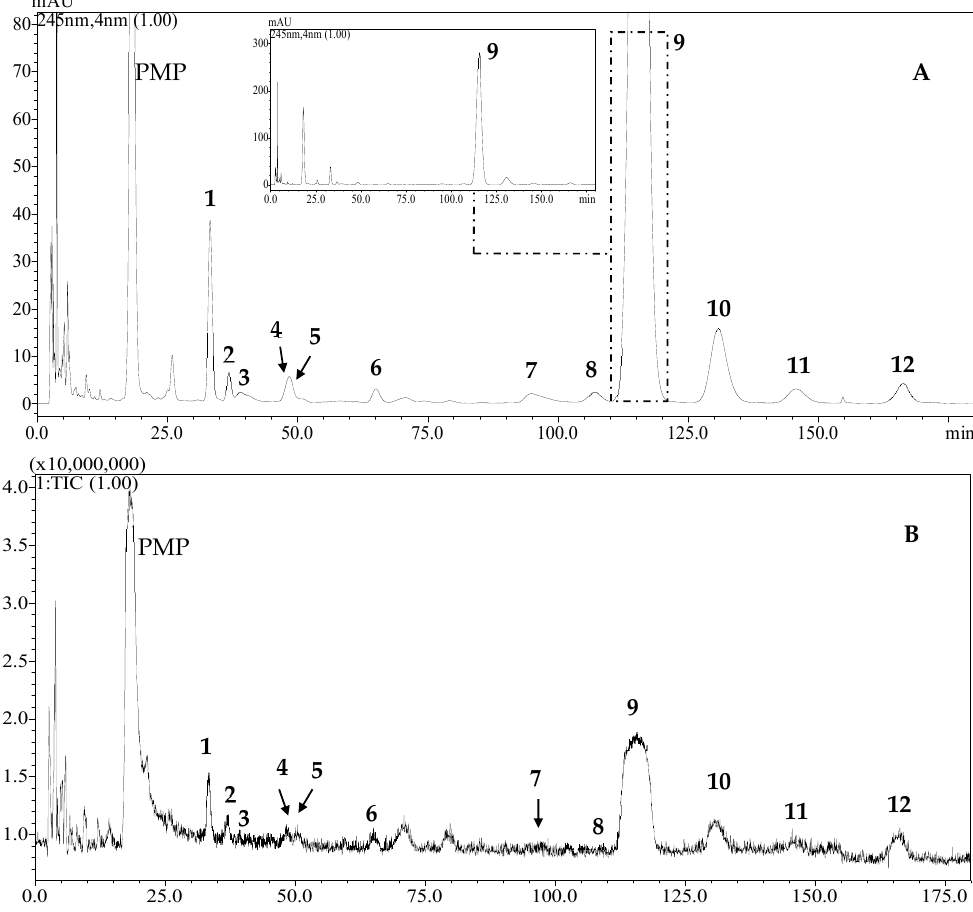
Figure 1. The HPLC chromatogram ( A ) and total ion chromatogram (TIC) in positive mode ( B ) of 12 1-phenyl-3-methyl-5-pyrazolone (PMP)-labeled monosaccharides. 1 , mannose; 2 , glucosamine; 3 , lyxose; 4 , rhamnose; 5 , ribose; 6 , erythrose; 7 , glucuronic acid; 8 , galacturonic acid; 9 , glucose; 10 , galactose; 11 , xylose; 12 , fucose.